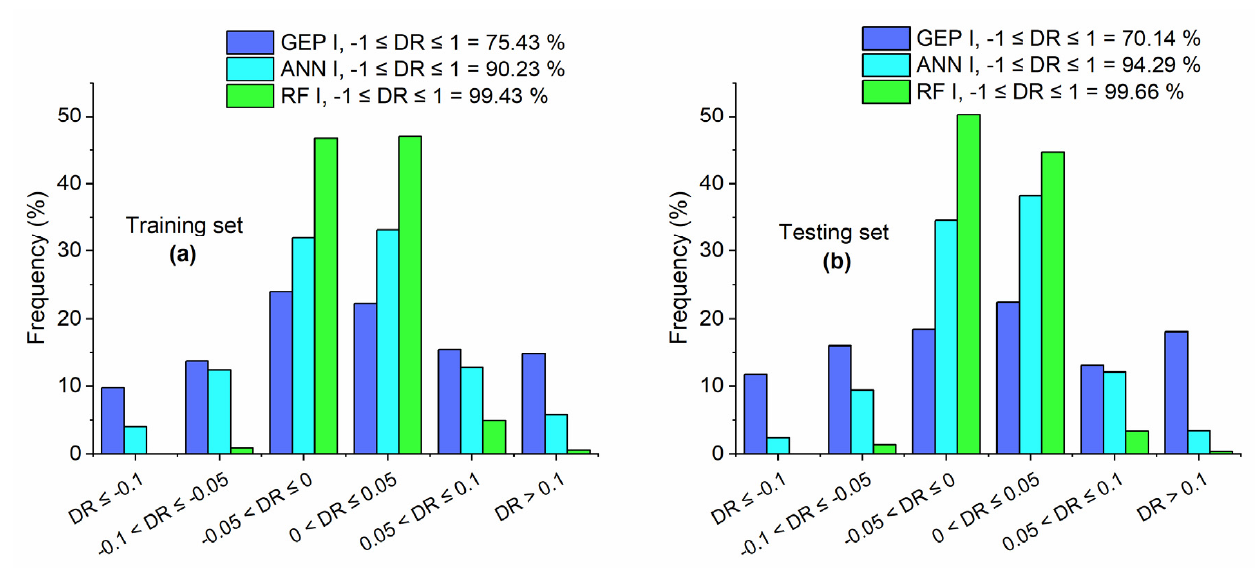
of fly ash based c